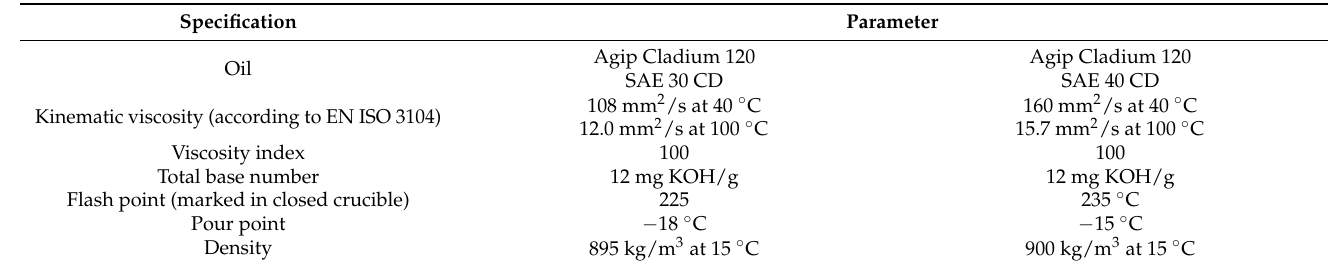
Table A5. Basic characteristics of several machines to study the lubricating properties (compiled from [65,77]).